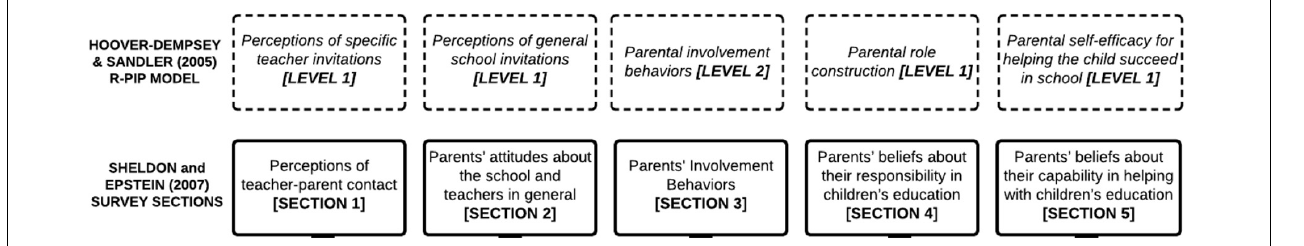
Children’s Mathematics